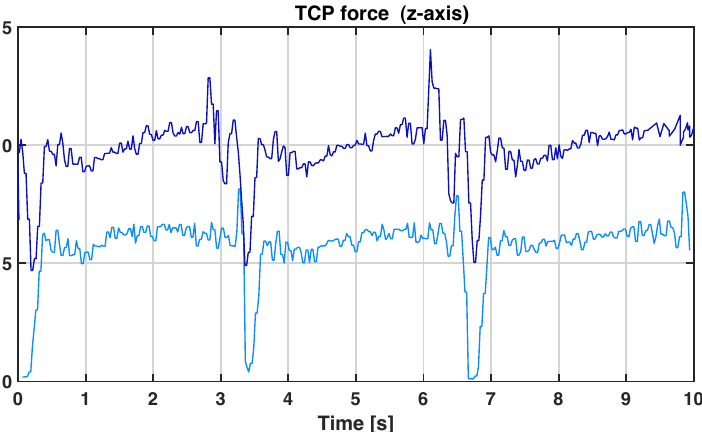
Figure 17. TCP force estimation along z axis during the execution of the PTP(1) motion command of the palletizing program. In dark blue, the estimation during the execution of three subsequential PTP(1) motions with a 1 kg load is represented. In light blue, the estimation during the execution of the same motion commands with cobot unloaded is